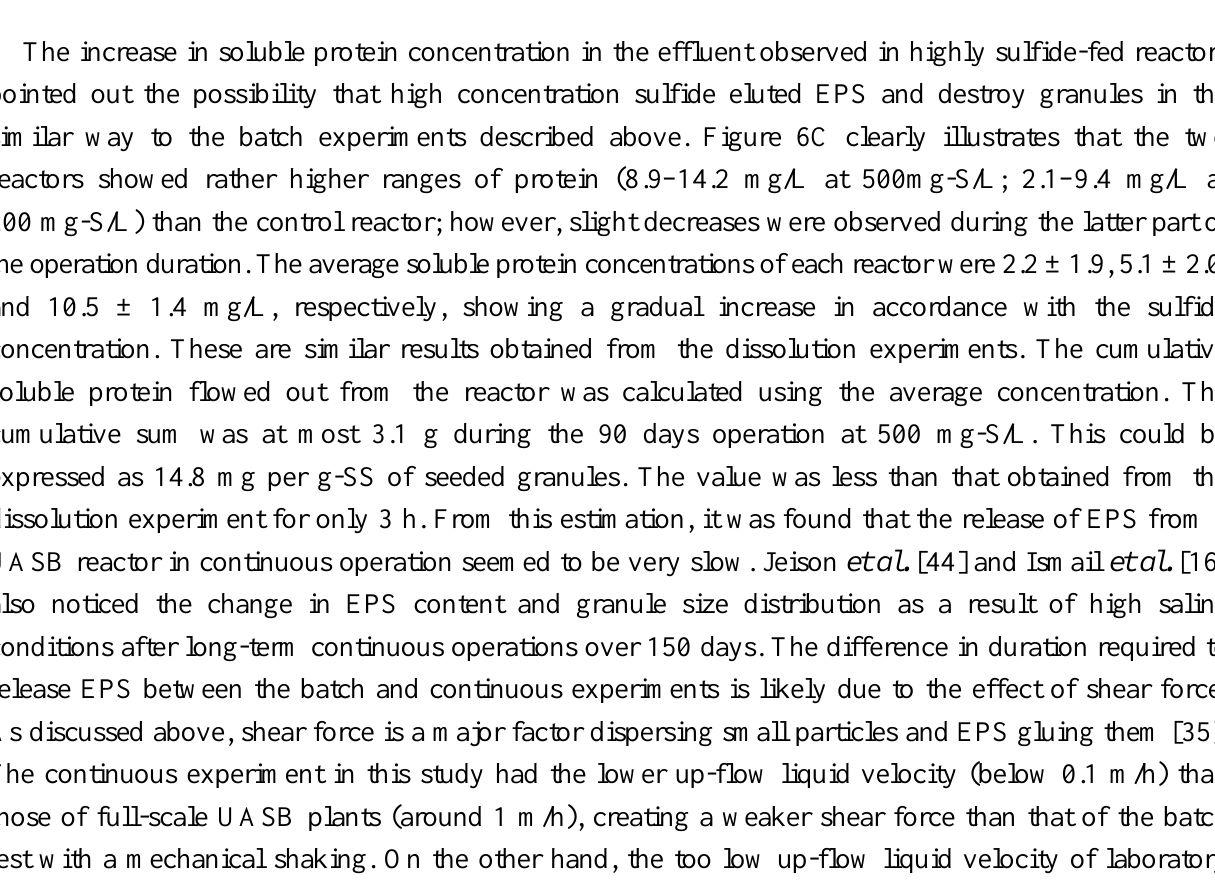
Figure 7. Time courses of the mixed liquor volatile suspended solids (MLVSS) of sludge in UASB reactors ( A ) and median diameter of the particles obtained from the middle part of the UASB reactor ( B